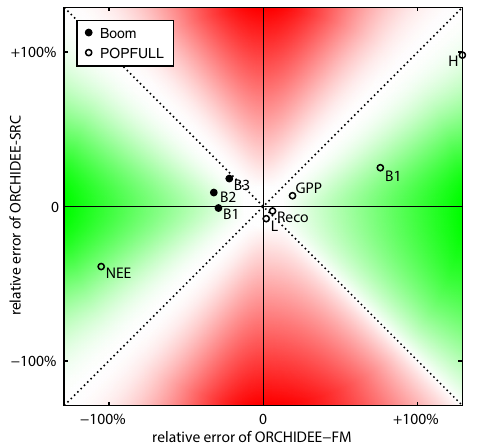
Figure 1. Comparison between the performance of the ORCHIDEE-SRC and ORCHIDEE-FM. The relative error was calculated as the relative difference between the field mea- surements and the model simulations. The green background indicates an improvement by the extended model relative to ORCHIDEE-FM, and the red background indicates a deterioration of the model results from the extended model. A darker colour indicates a more pronounced difference. The Boom site simulations are shown as filled circles, and the POPFULL site simulations are shown as open circles. The letters next to the symbol are as follows: GPP indicates gross primary productivity cumulated over the 2 measurement years; Reco the ecosystem respiration cumulated over the 2 measurement years; NEE the net ecosystem exchange cumulated over the 2 measurement years; LE the latent heat cumulated over the 2 measurement years; H the sensible heat cumulated over the 2 measurement years; B x the aboveground woody biomass production of rotation x .